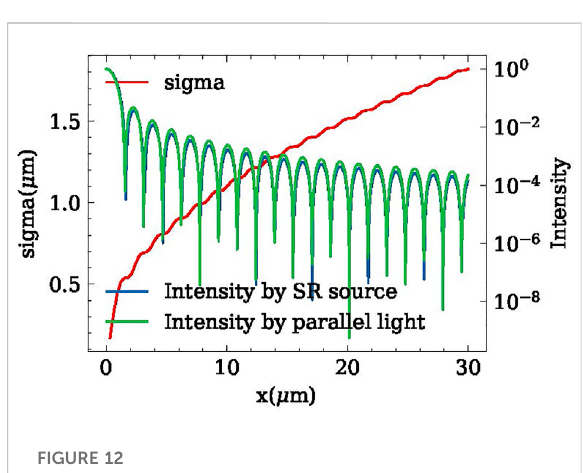
FIGURE 12 RMS spot size calculation for single slit